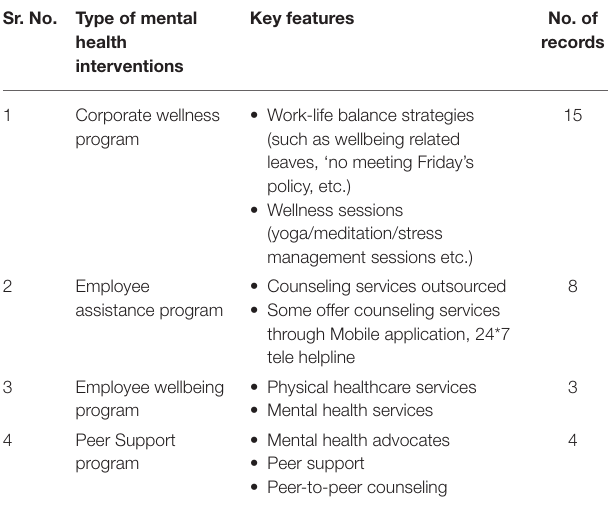
TABLE 1 | Classification of workplace mental health